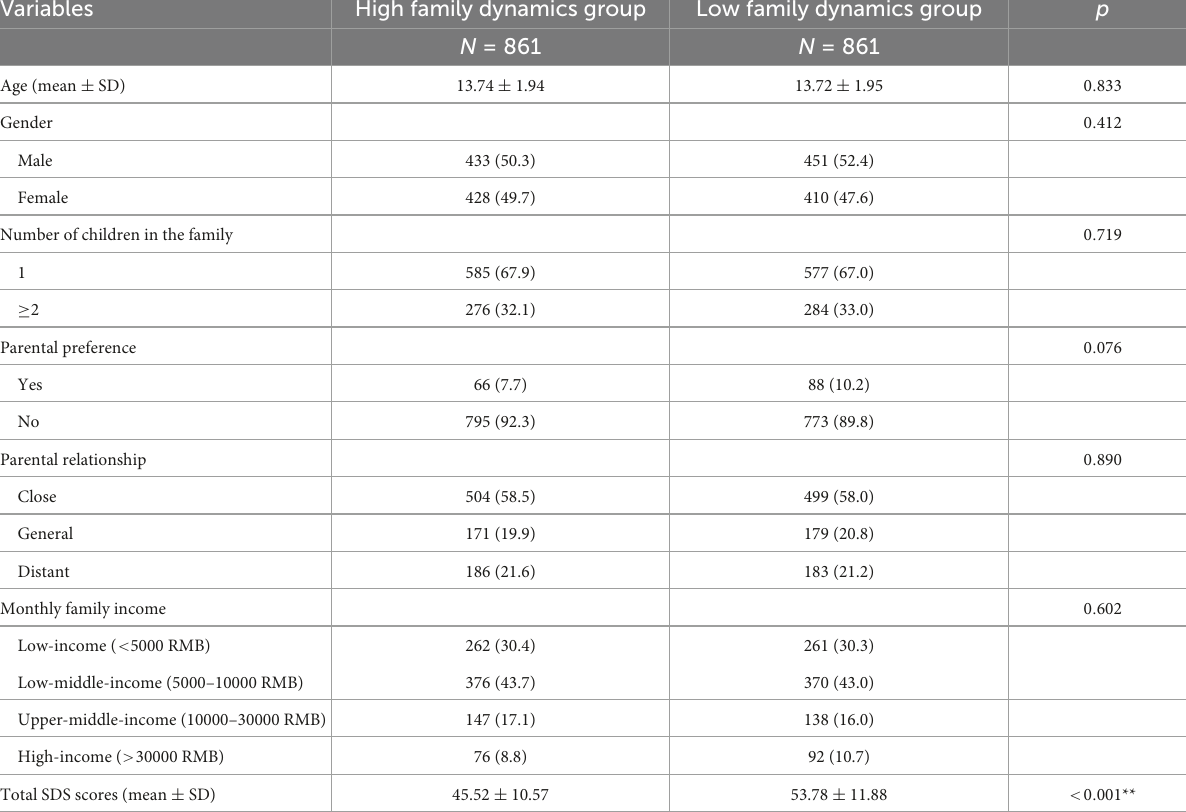
TABLE 6 Comparison of demographic characteristics and total SDS scores among two latent groups after PSM